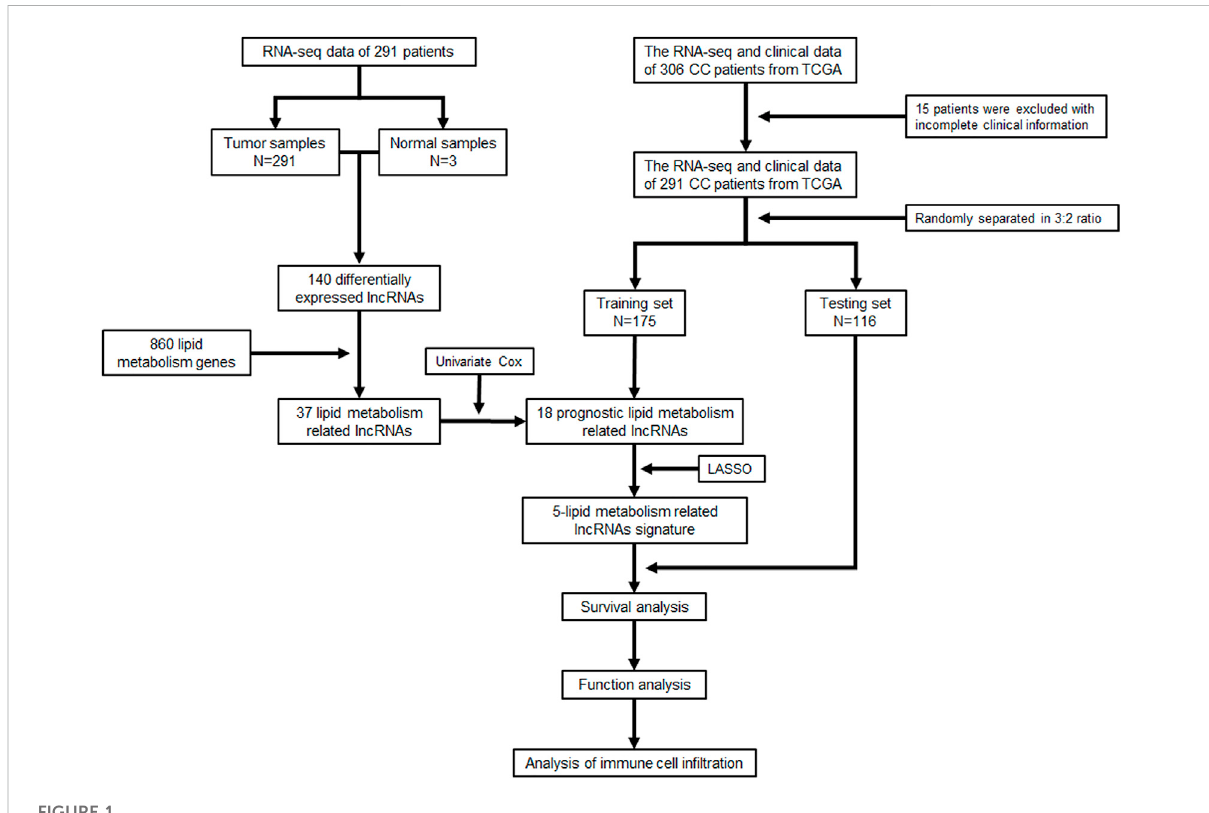
FIGURE 1 Flowchart of the